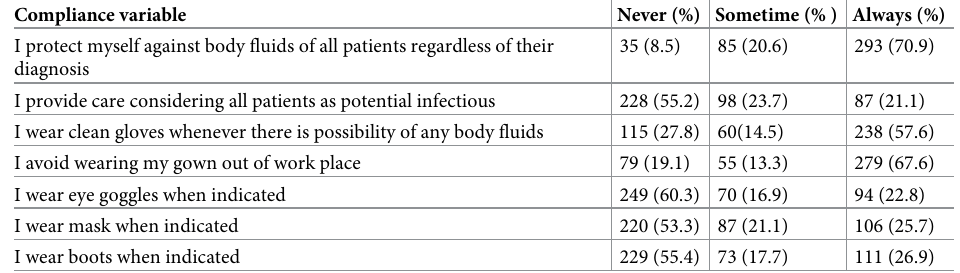
Table 2. Compliance with personal protective safety precautions among healthcare workers of Hawassa compre- hensive specialized hospital, 2019.